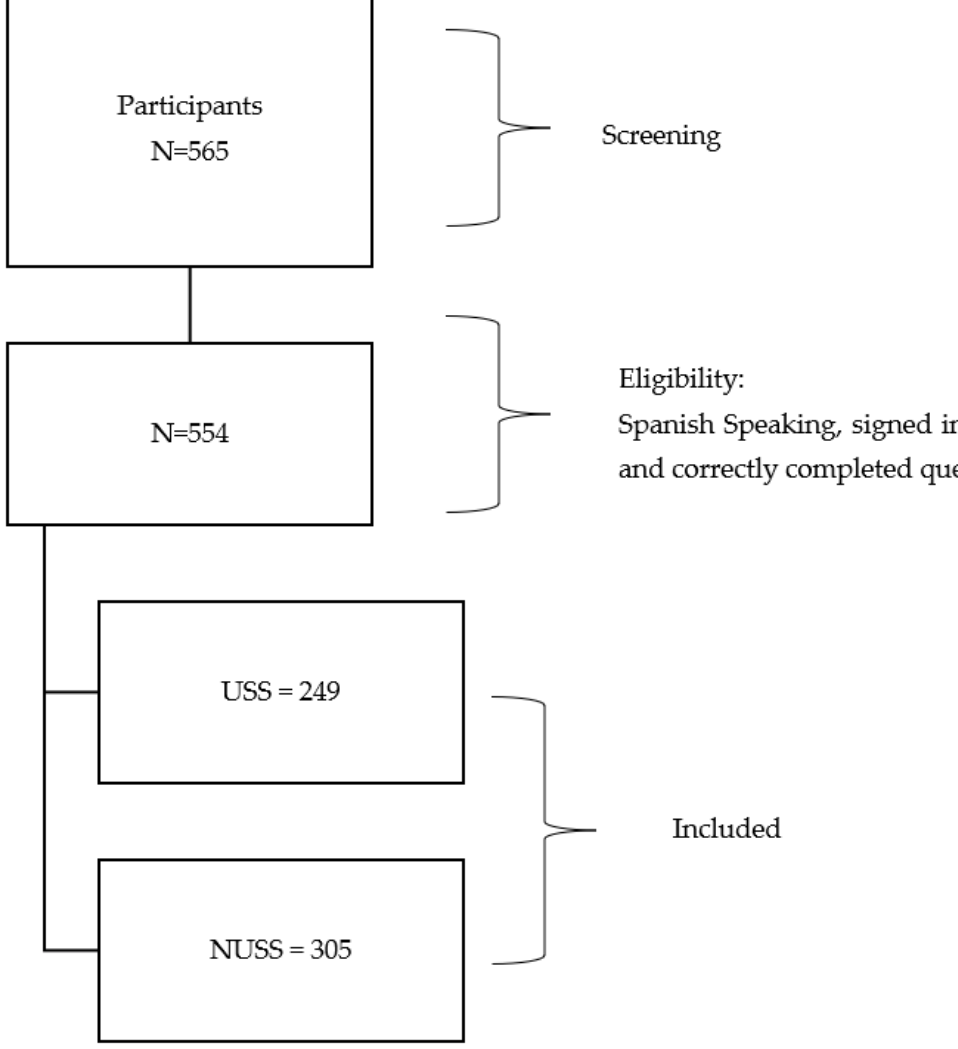
Figure 1. Flow chart detailing the study participants. USS, Sports Supplement Users; NUSS, Non-users of Sports Supplements.